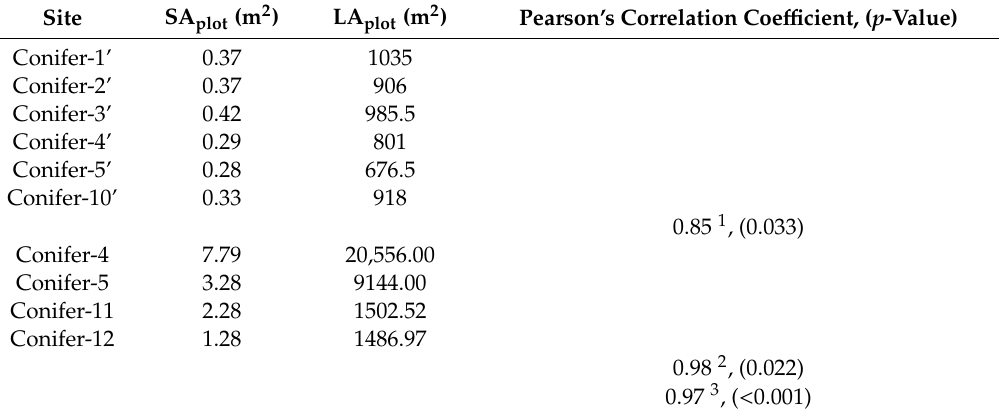
Table 5. Estimated sapwood area and their respective leaf area per stand, conifer sites. The first six sites are of size 10 × 10 m while the last four are of 60 × 60 m.